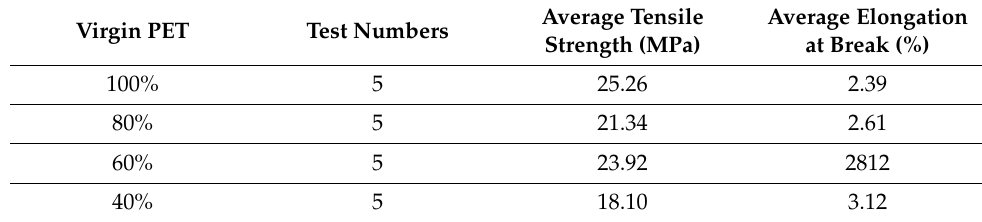
Figure 5. Tensile elongation of a recycled ( a ) and virgin ( b ) 3D printed PET. Table 5. Tensile strength and elongation at break of virgin PET filament.